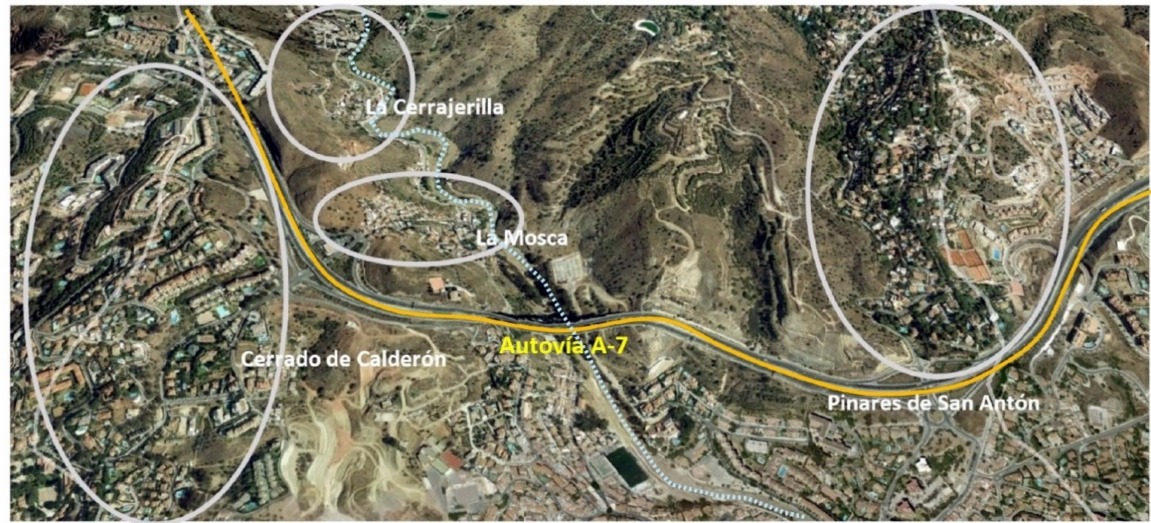
Figure 7. Peri-urban growth in the Jaboneros stream basin. Along with the land occupied by road infrastructures, there are four residential developments with different construction typologies and socio-economic levels (Cerrado de Calder ó n, Pinares de San Ant ó n, La Mosca, and La Cerrajerilla). The first two of these are standard residential developments, but the third is characterized by informal, unplanned construction, poor organization, and few services. The fourth exemplifies diffuse residential